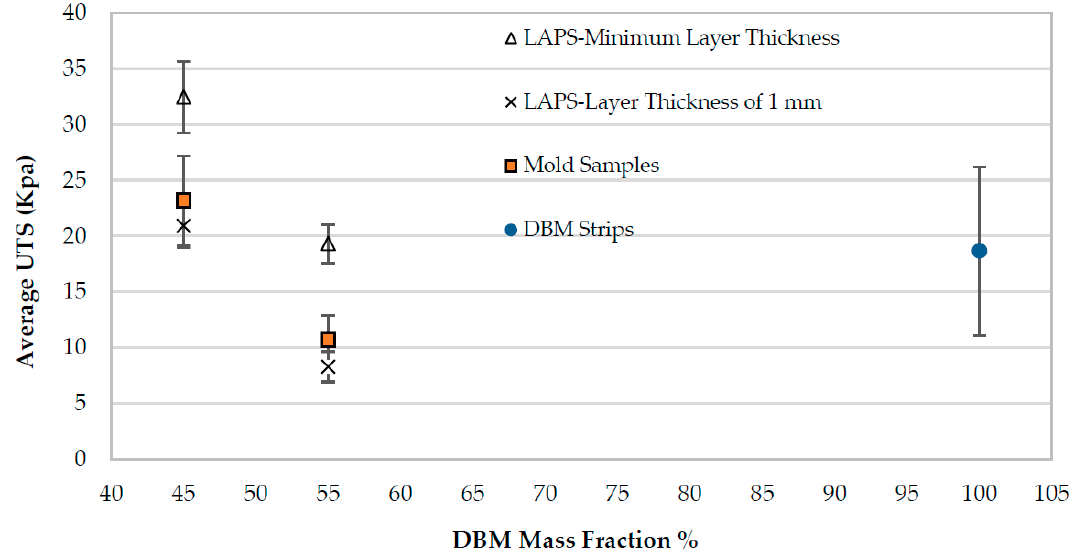
Figure 6. Comparison of the ultimate tensile strengths for natural cancellous bone and PCL/demineralized bone matrix (DBM) composites fabricated by heating in a mold and LAPS with varied layer thickness. All testing was done in the dry state.